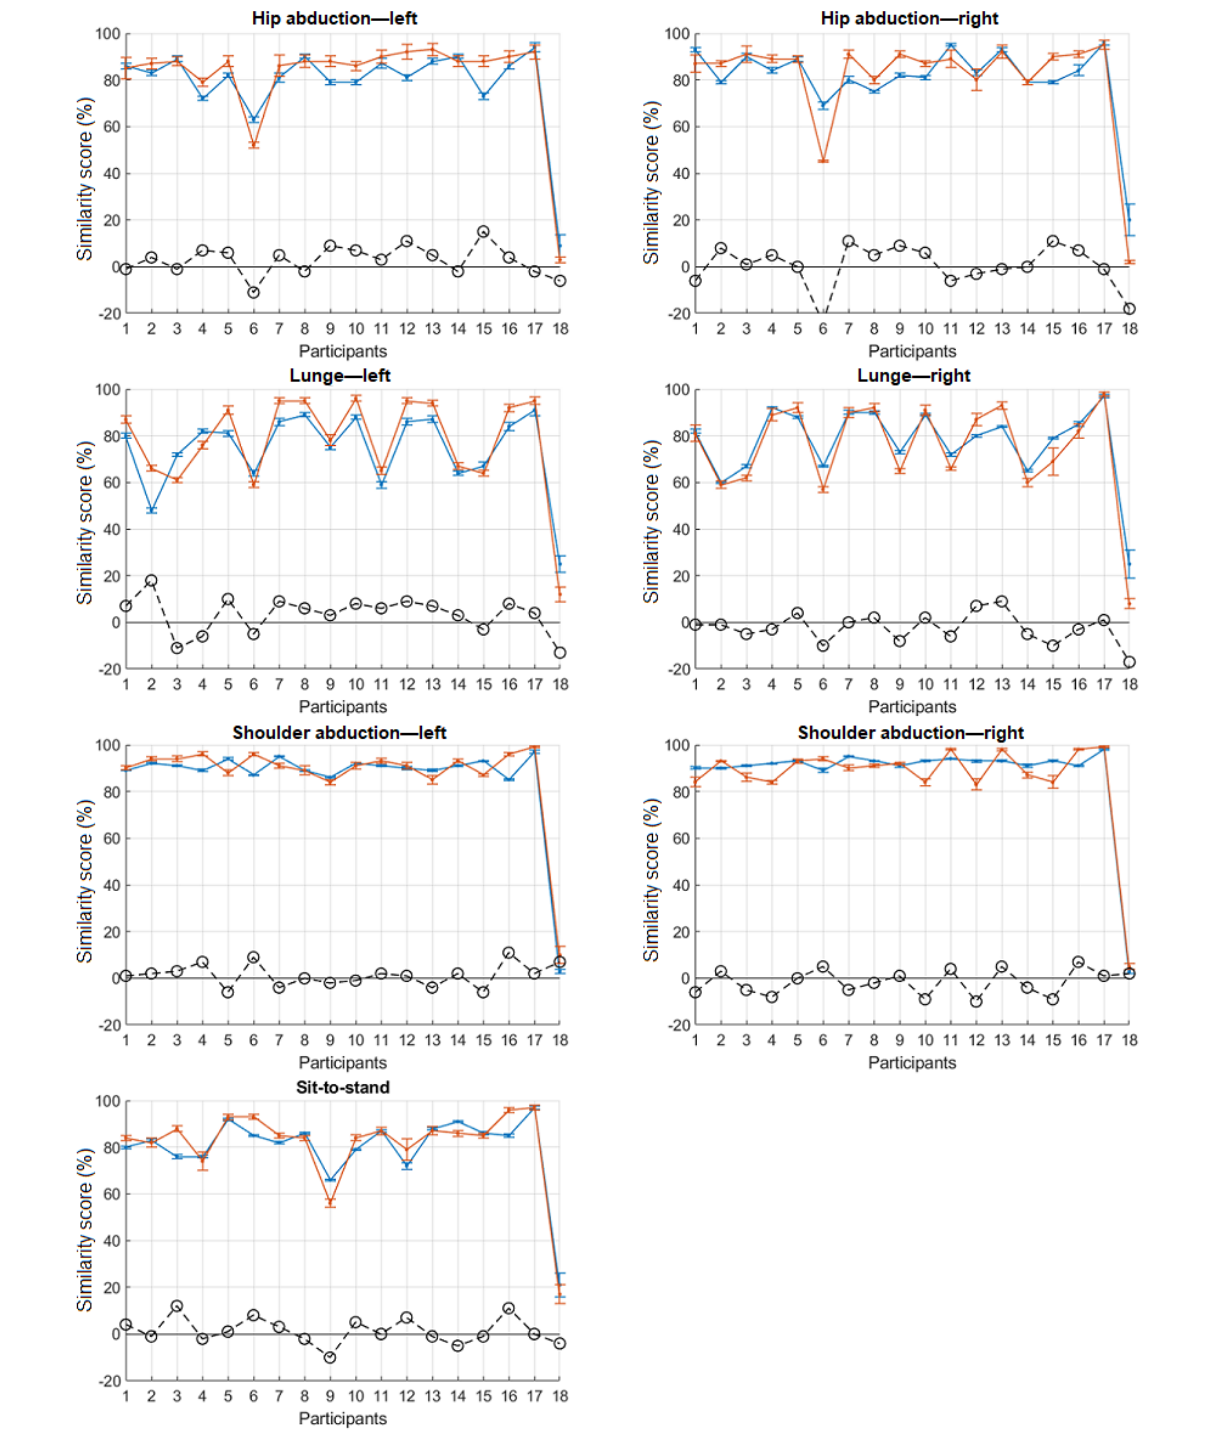
Figure 6. Similarity scores obtained from applying dynamic time warping (SD, solid blue line) and hidden Markov model (SH, solid red line). Their difference, SH-SD, is shown by the black dashed line. Participant 17 is the physiotherapist and 18 is the worst performance, that is, making no movement. Error bars indicate standard